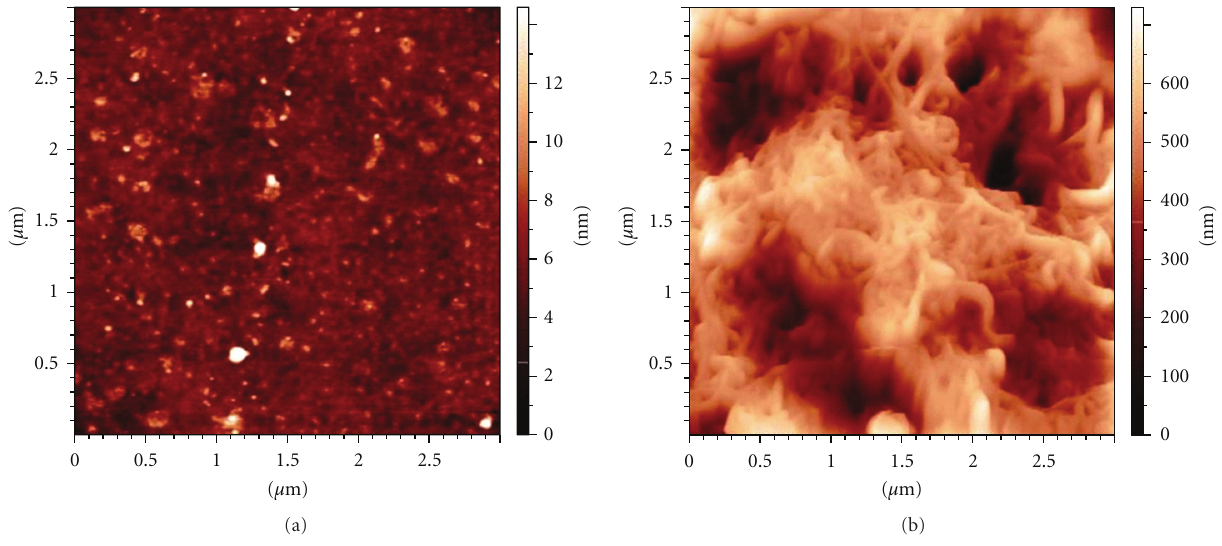
Figure 2: AFM images of (a) uncoated-CS and (b) SWCNTs CS substrates. Table 1: Adhesion of Streptococcus mutans ATCC 25175 T and Pseudomonas aeruginosa ATCC 15692 on uncoated- and SWCNT-coated-GBs.